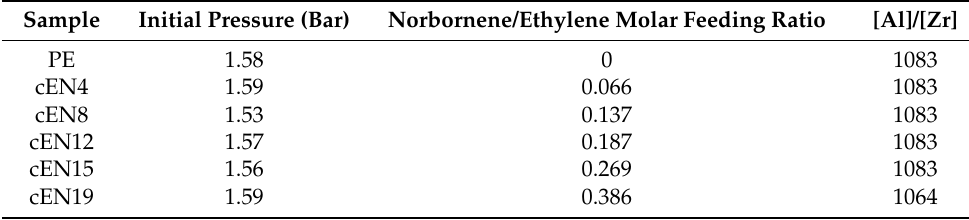
Table 1. Synthetic parameters involved in the synthetic procedure.